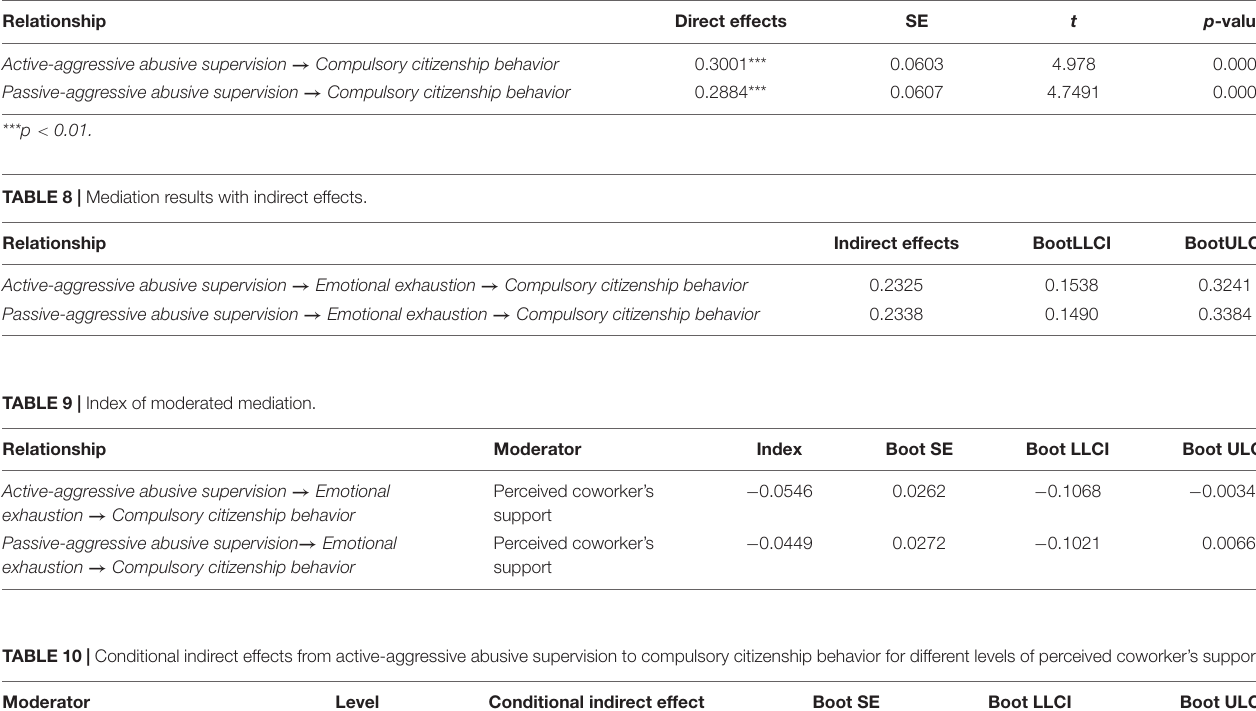
TABLE 7 | Mediation results with direct effects.